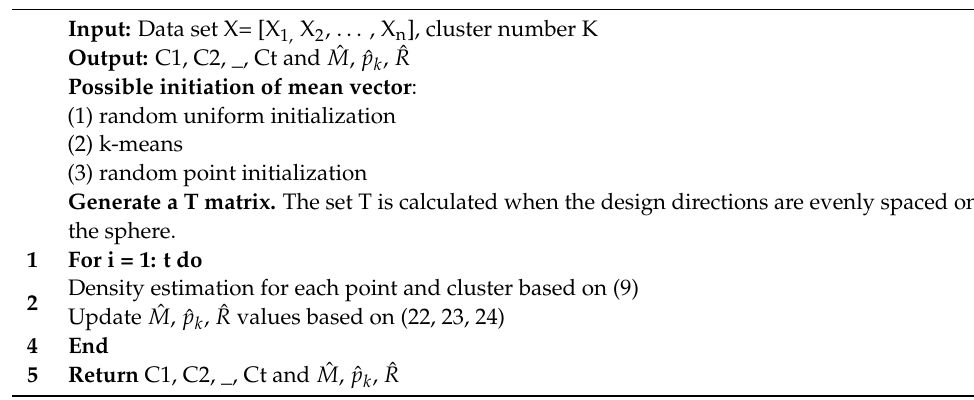
Algorithm 1: Clustering Algorithm Based on the Modified Inversion Formula Density Estimation